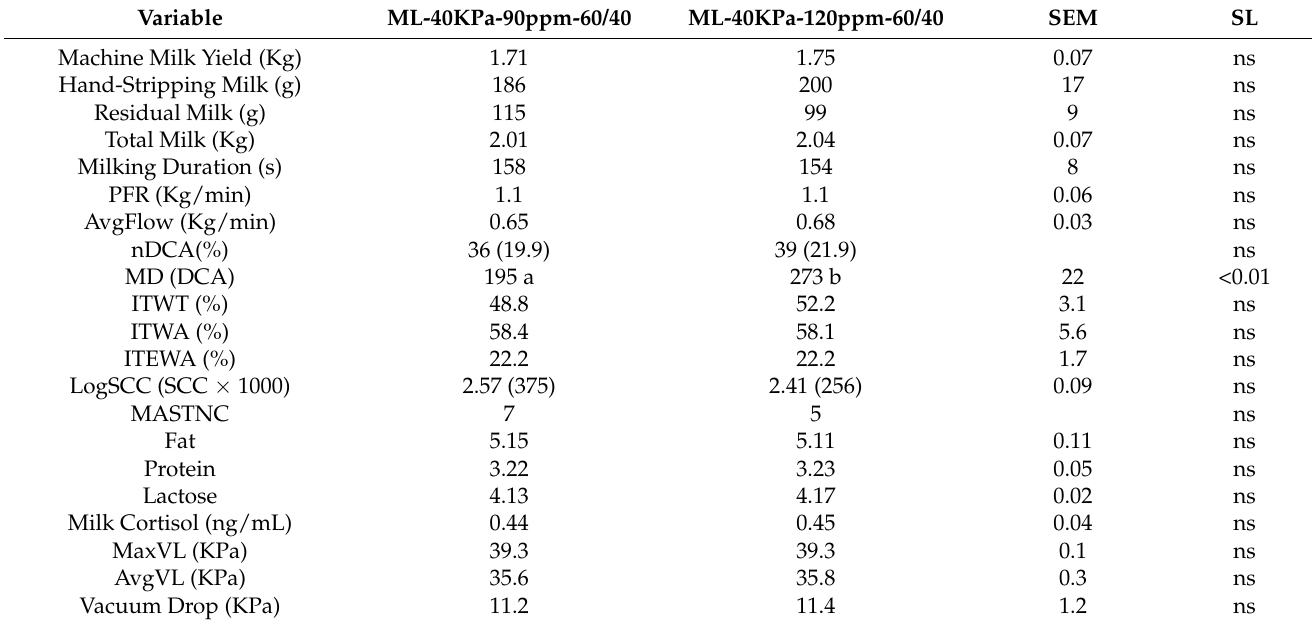
Table 3. Experiment developed in mid-lines pipes milking system: results of the variables studied (least square means ± standard error of the mean) according to the different combinations of system vacuum level and pulsation